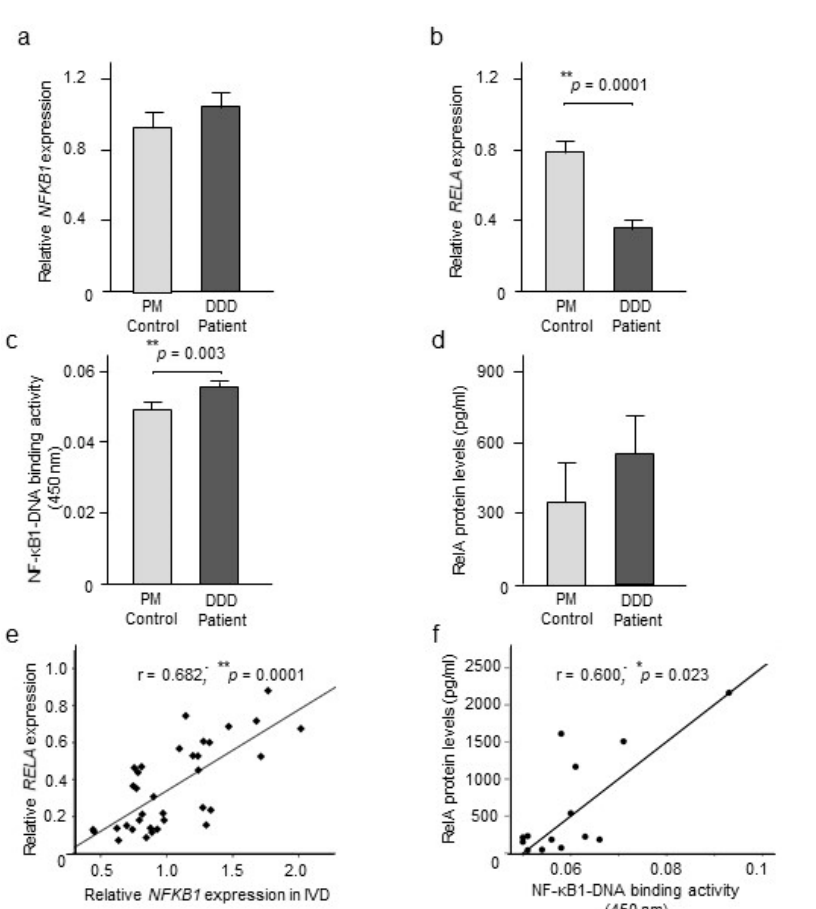
Figure 1. NF- κ B expression and activation state in intervertebral disc (IVD) tissues. ( a ) Relative expression of NFKB1 ( n = 33 DDD patients and 17 PM control samples) and ( b ) RELA gene expression ( n = 33 DDD patients and 16 PM control samples) in the IVD tissues retrieved from DDD patients and